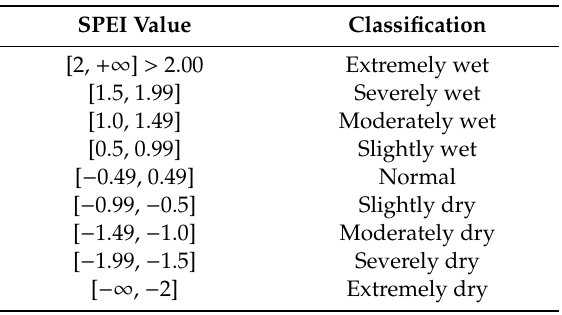
Table 1. SPEI meteorological drought index classification